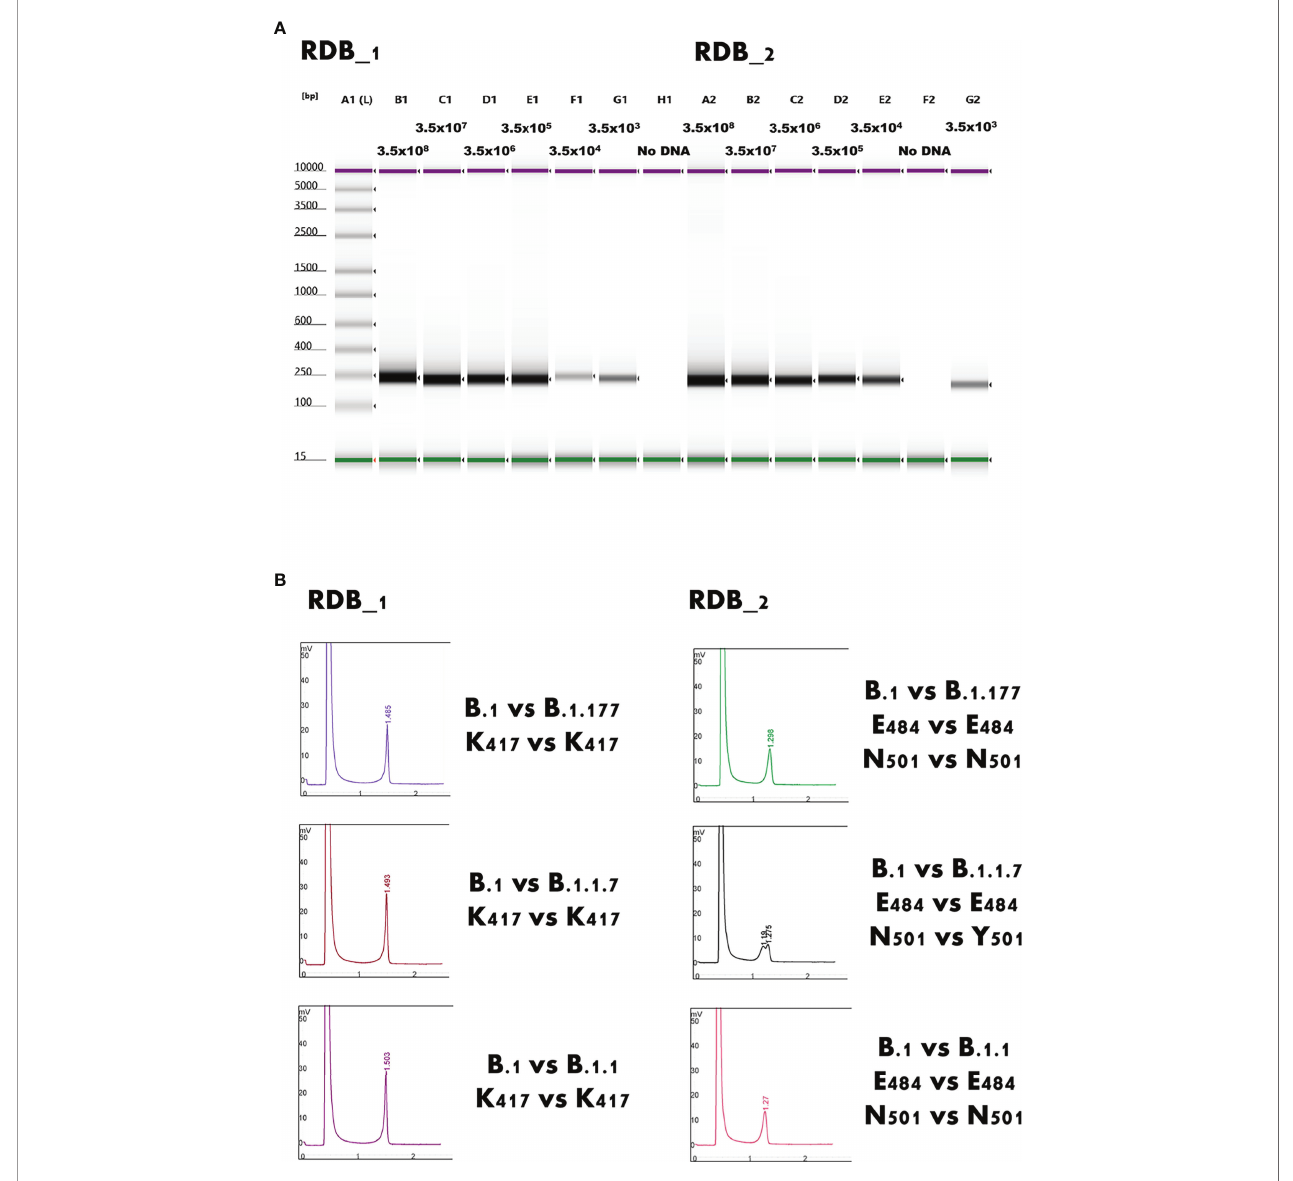
FIGURE 2 | (A) Gel image of the electrophoresis analysis of the RBD_1 and RBD_2 end-point PCR. A1 lane shows the sizing ladder. Purple and green bands represent the upper and lower markers, respectively. The expected viral load expressed as copies/mL are indicated above each lane. Discrete sharp bands without smearing or additional non-speci fi c bands are clearly identi fi able in all cases. RBD: Receptor Binding Domain of SARS-CoV-2. (B) Detection of Y501 residue (B.1.1.7 variant) throughout heteroduplex detection between the region binding domain Target 2 (RBD_2) ampli fi ed from a B.1 strain and a B.1.1.7 strain. The mixing, denaturing at 95°C, and renaturing at room temperature between two mutations causes a heteroduplex formation detected by the Wave Denaturing high- performance liquid chromatography system, such as peak splitting N501 vs Y501. All other examples represent the typical appearance of